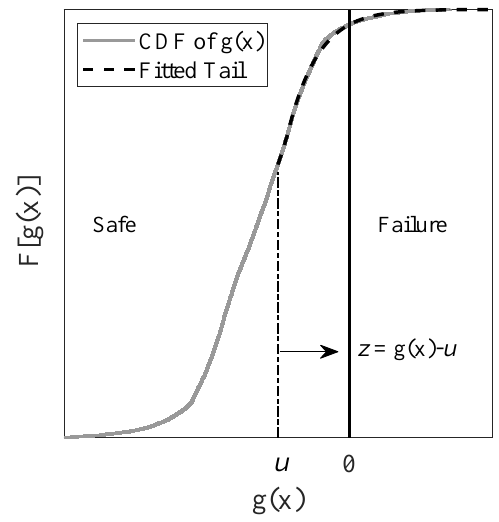
Figure 1. Concept of tail